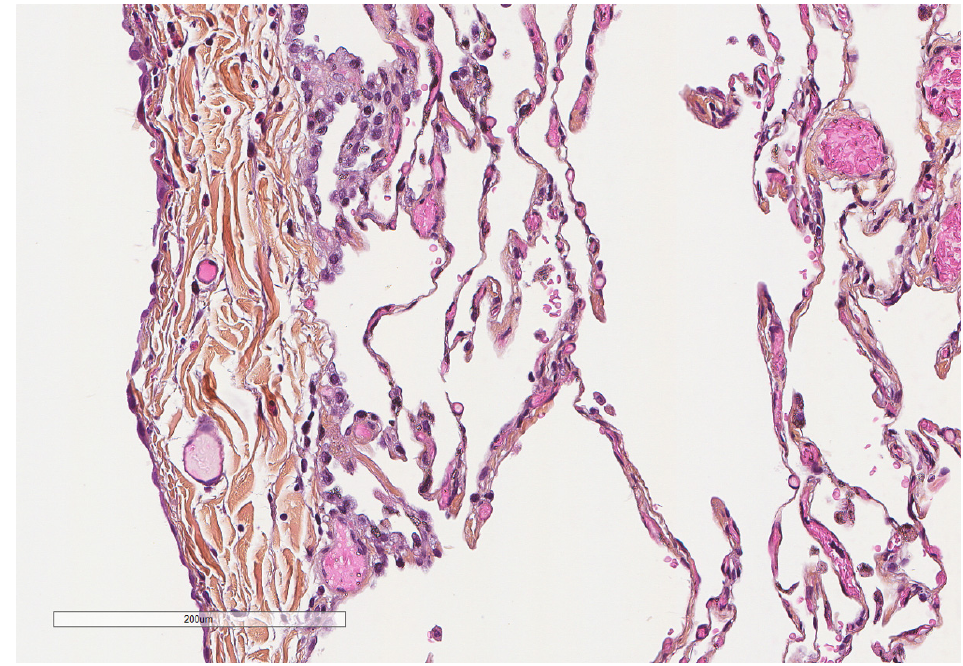
Figure 3. Microscopic aspect of the visceral pleura (left) covering the underlying alveoli. Hematoxylin, eosin, saffron staining (×200).